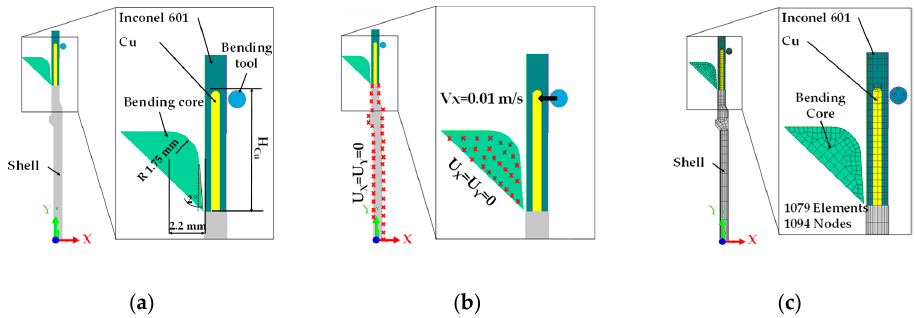
Figure 12. Schematic representation of ( a ) the geometry of the workpiece and the bending tools, ( b